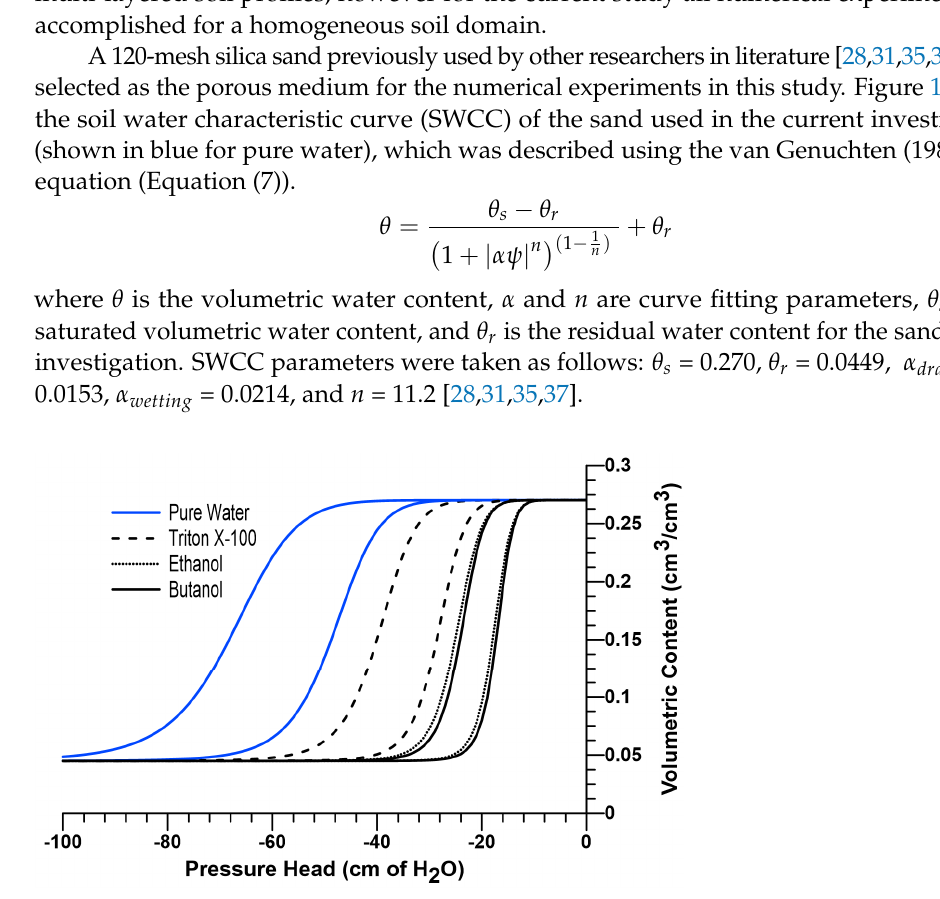
Figure 1. Soil water characteristic curves for pure water, Triton X-100 (1 g/L), pure ethanol and 7% w/w butanol solutions.